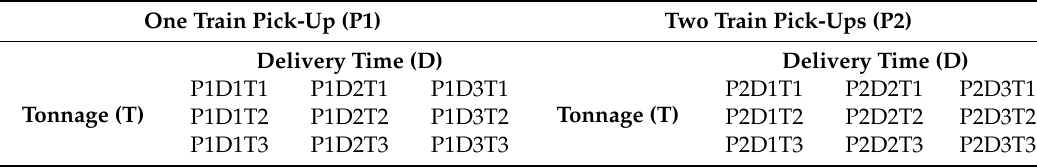
Table 1. 18 scenario settings for simulation.